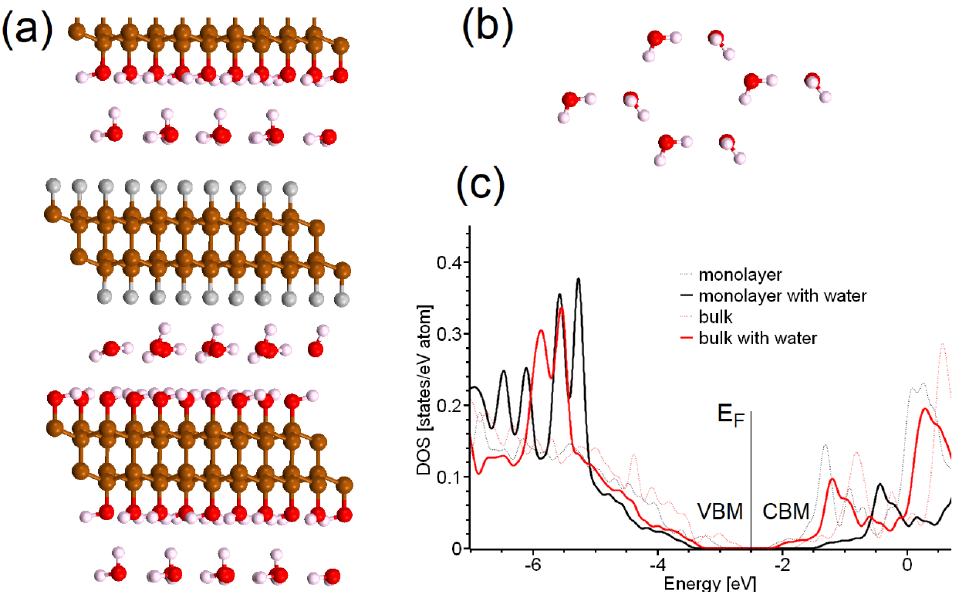
Figure 3. ( a ) Side view of optimized atomic structure of bulk C 2 F/C 2 OH system intercalated by water, and ( b ) top view of hexagonal patterns formed by water in the interlayer space of the structure presented in panel ( a ). ( c ) Total densities of states of C 2 F/C 2 OH single layer and bulk intercalated by water (solid lines), and total densities of states of corresponding structures without water. The color scale of the atoms in panel ( a ) is the same as in Figure 1.